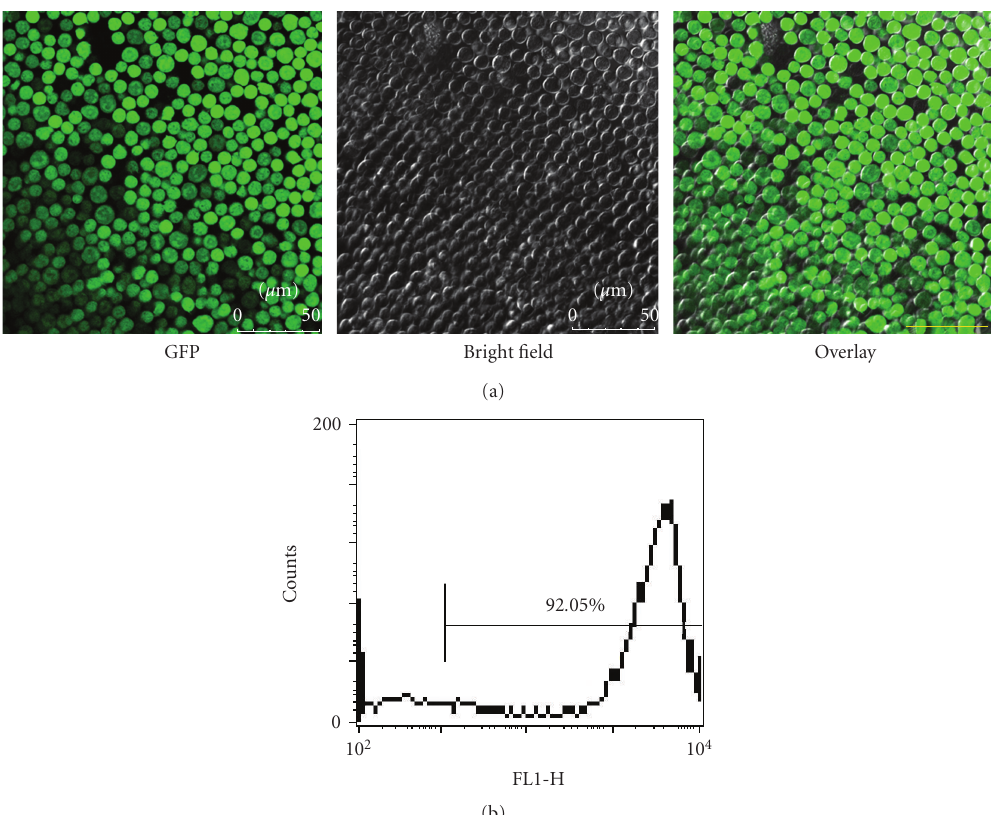
Figure 1: Recipient’s bone marrow was reconstituted by transplantation of donor’s GFP positive BMDCs. (a) GFP positive marrow cells took up the majority of chimeric bone marrow two months after transplantation. Bar = 50 μ m. (b) the percentage of GFP positive marrow cells in chimeric marrow at two months after transplantation was shown to be 92.05% by flow